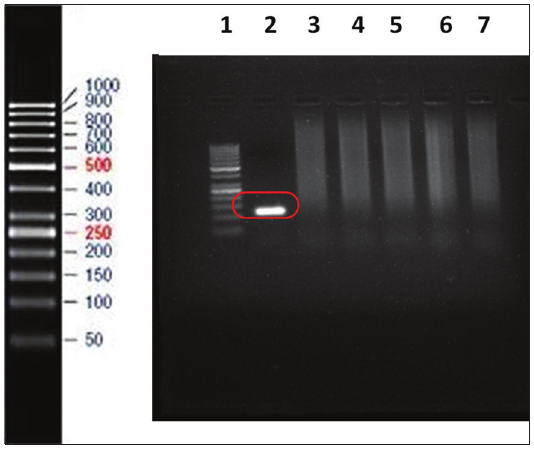
Figure-1: Specificity analysis of the ISMap 02 element by a conventional nested polymerase chain reaction protocol for amplification of a 117-bp product from DNA isolated from bacterial cultures of various species of mycobacteria and two non-mycobacterial species. Lane 1, 50-bp molecular mass marker; lane 2 Mycobacterium avium subsp. paratuberculosi s; lane 3 Mycobacterium bovis ; lane 4 Mycobacterium tuberculosis ; lanes 5 Mycobacterium smegmatis ; lane 6 E. coli ; lane 7 Pasteurella multocida.